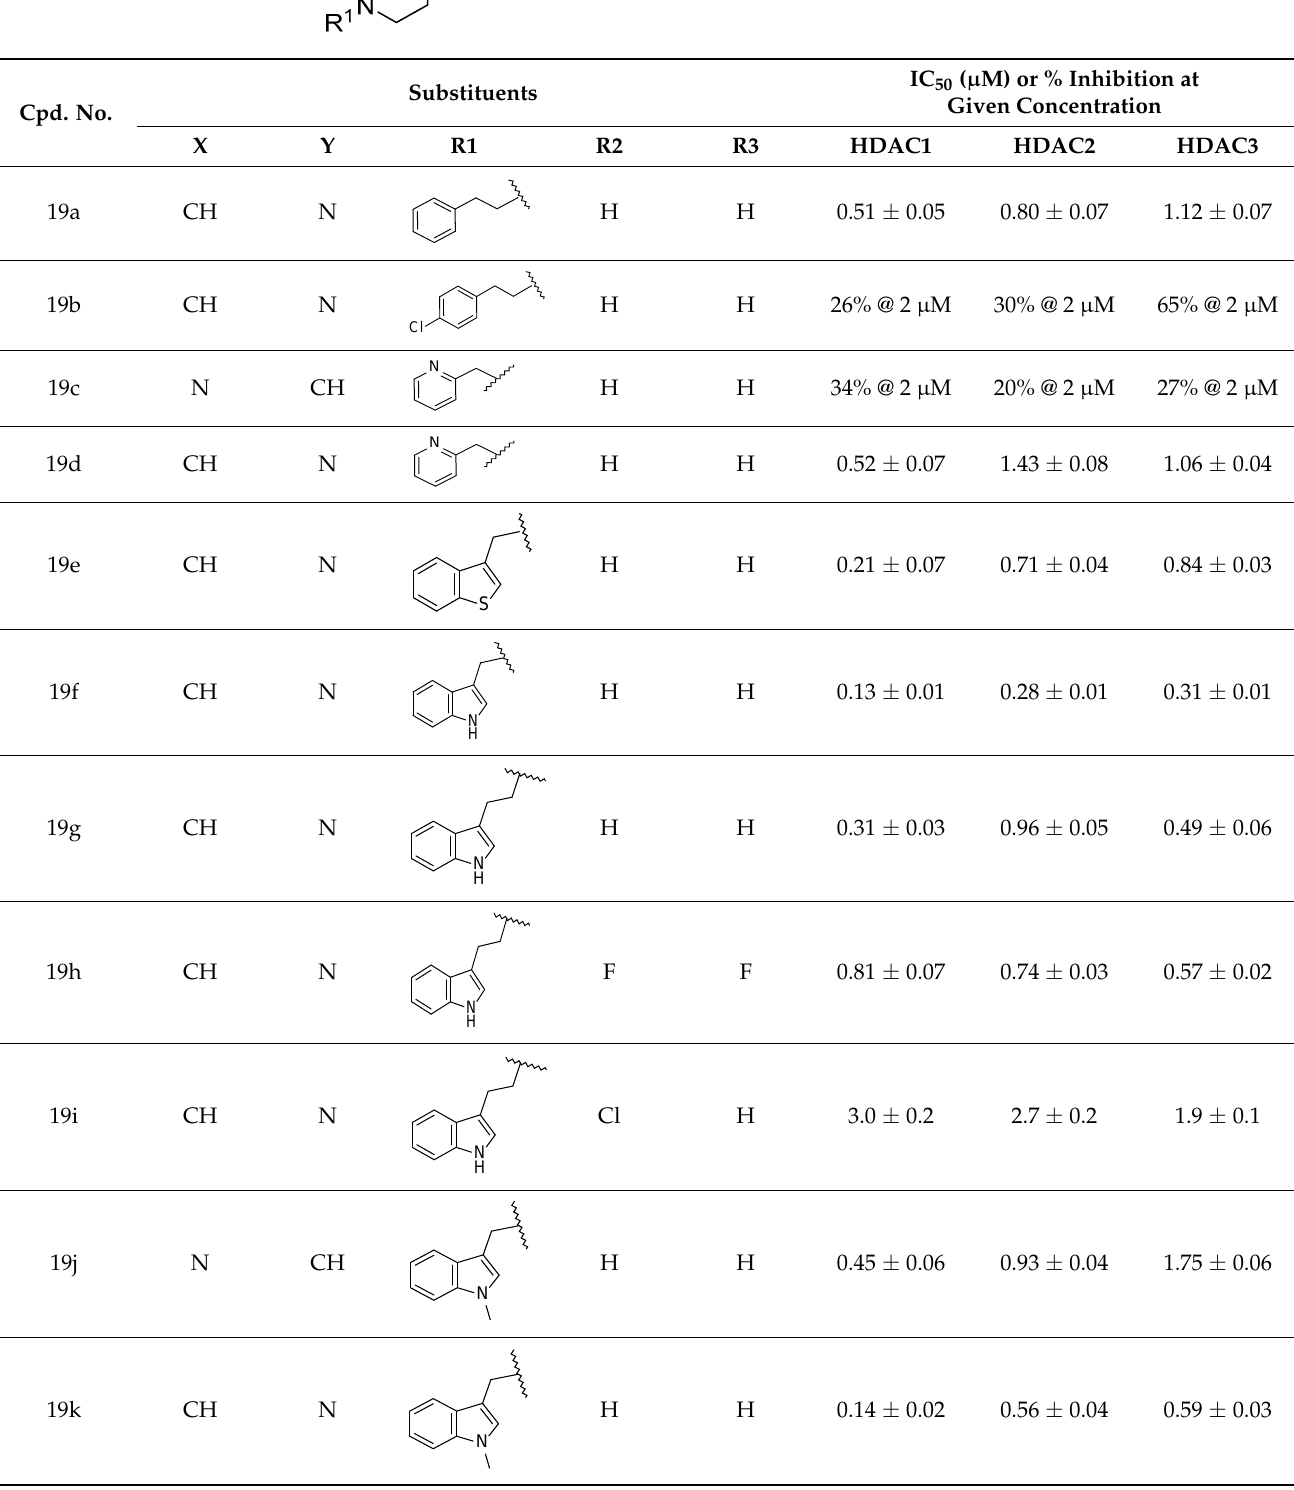
Table 1. Inhibitory activity of synthesized compounds of the training set against HDAC1-3 [25] .